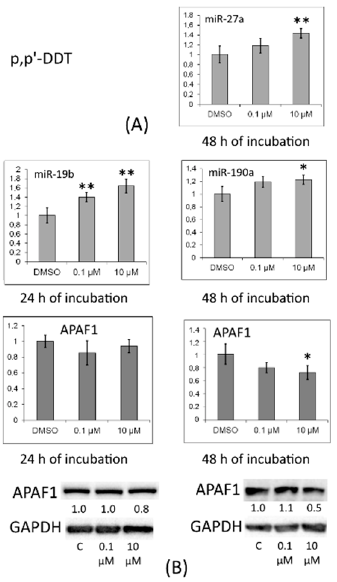
Figure 7. ( A ) Relative level of miR-190a in MCF-7 cells exposed to o,p (cid:48) -DDT for 48 h. The Y-axis shows the ratio of the miRNA amount in the cells treated with a DDT isomer to the miRNA amount in the cells treated with DMSO. Each value is the mean of three independent experiments. * Significant differences from the control ( p < 0.05); ** p < 0.01. ( B ) Western blot analysis of TP53INP1 in cells incubated with o,p (cid:48) -DDT. The numbers under TP53INP1 bands denote fold change in the protein level as compared to the first band (control); each data point was normalized to the corresponding GAPDH band. We present findings from one of three independent experiments (which yielded similar results).